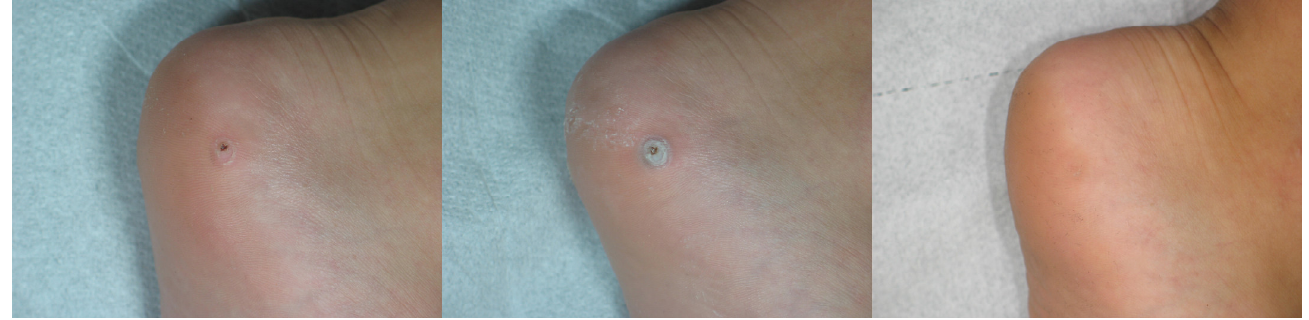
Figure 4. Patient n. 27 before treatment ( left ), immediately after combined treatment ( central ), and 4 months after treatment ( right ).